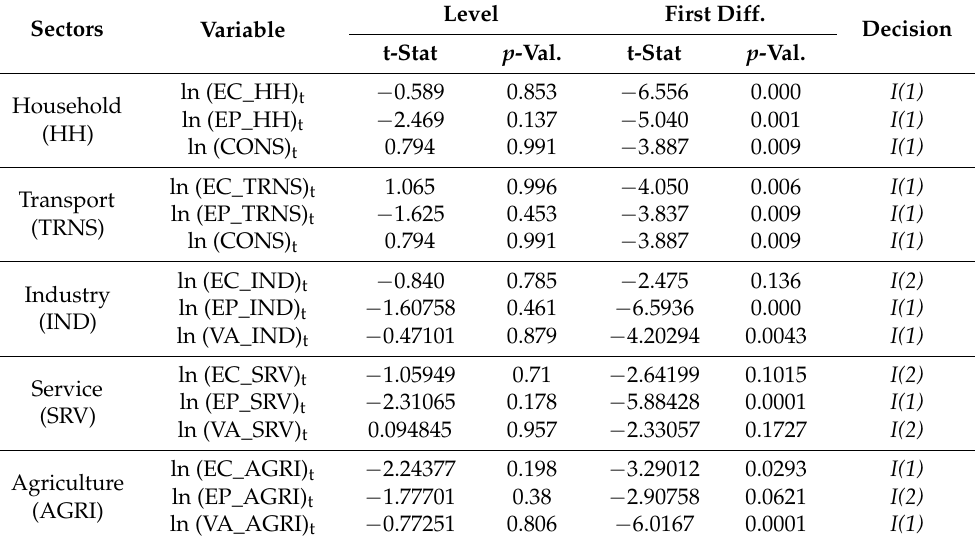
Table A1. Results for Augmented Dickey–Fuller test to check